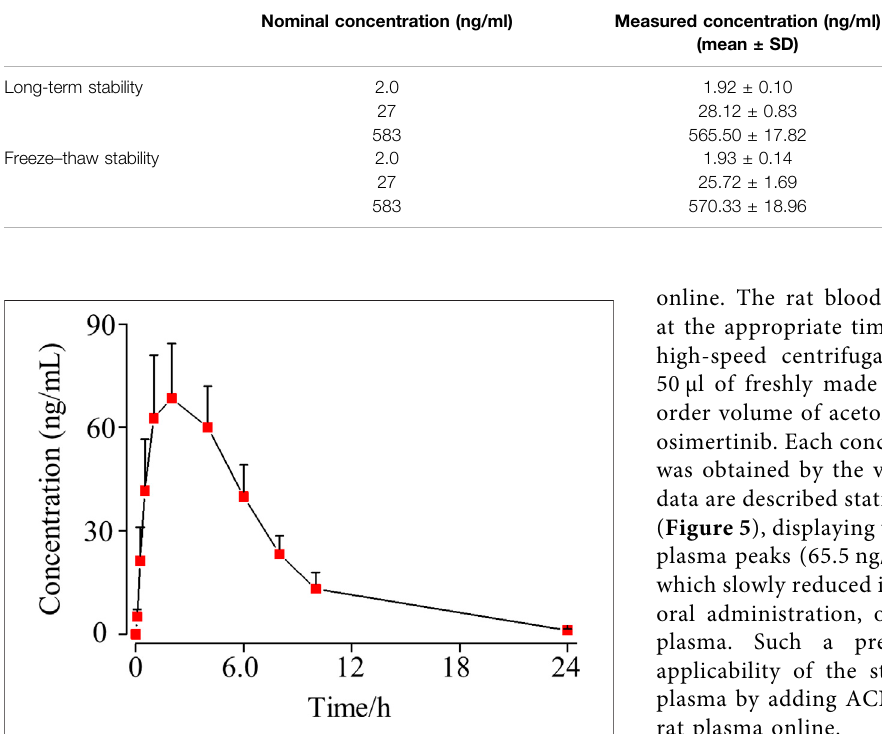
Frontiers in Pharmacology |